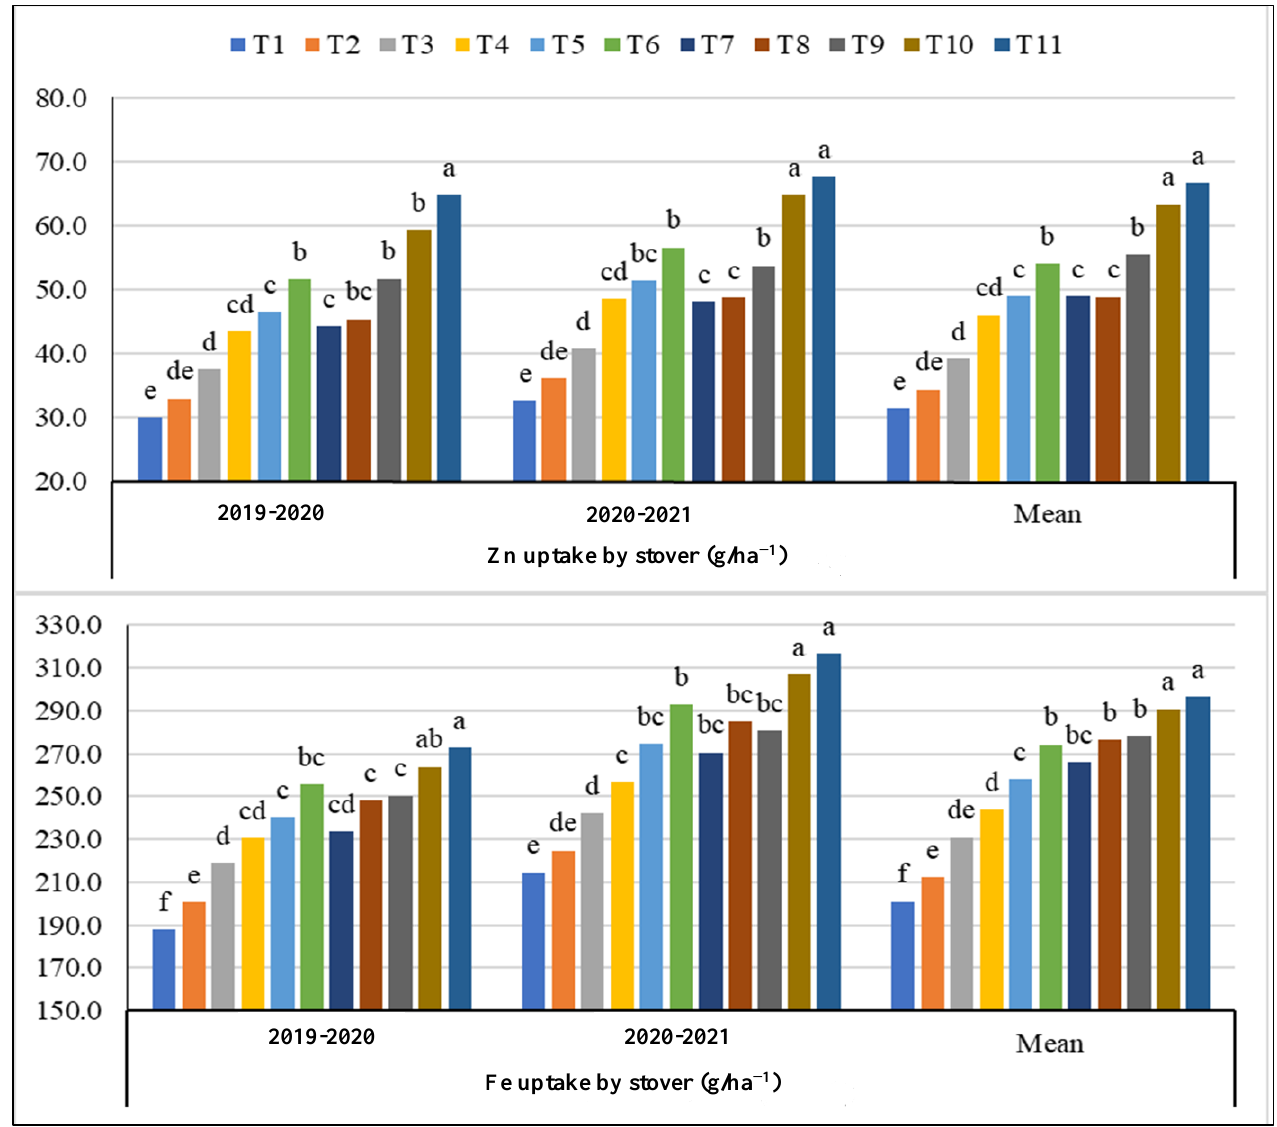
Figure 6. Effect of urea and micronutrients foliar spray on Zn uptake and Fe uptake by stover of Indian mustard. Treatments details are available in Table 1. The bar with a similar or dissimilar letter(s) was evaluated with the least significant difference (LSD) multiple range tests using a probability level of p ≤ 0.05.